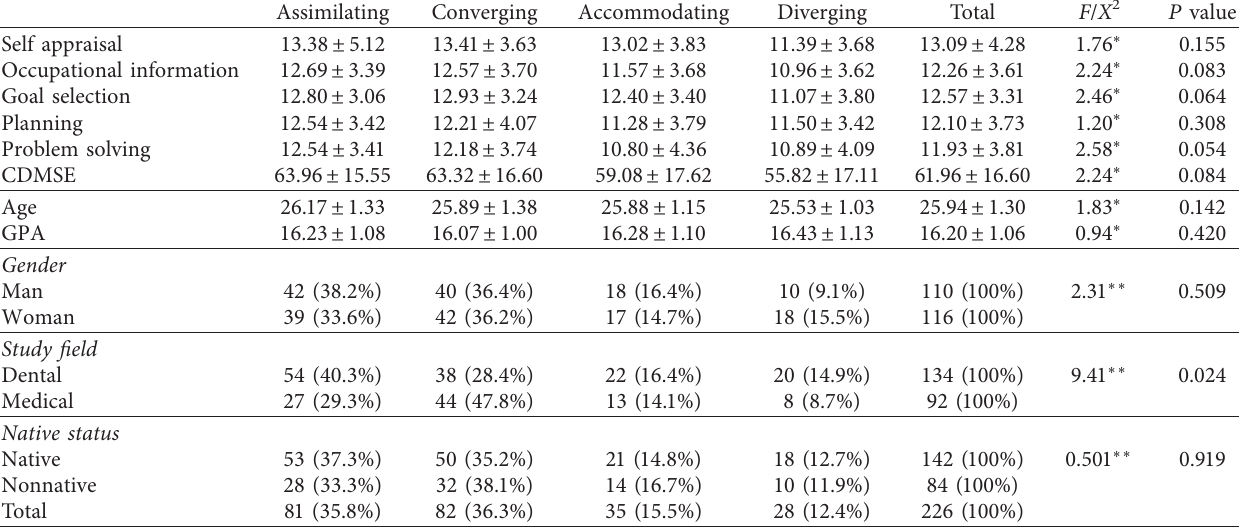
Table 1: Association between learning styles and demographic and academic variables of the study participants.